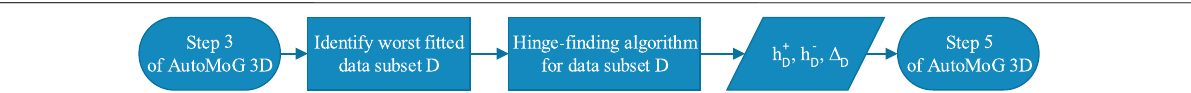
Frontiers in Energy Research |